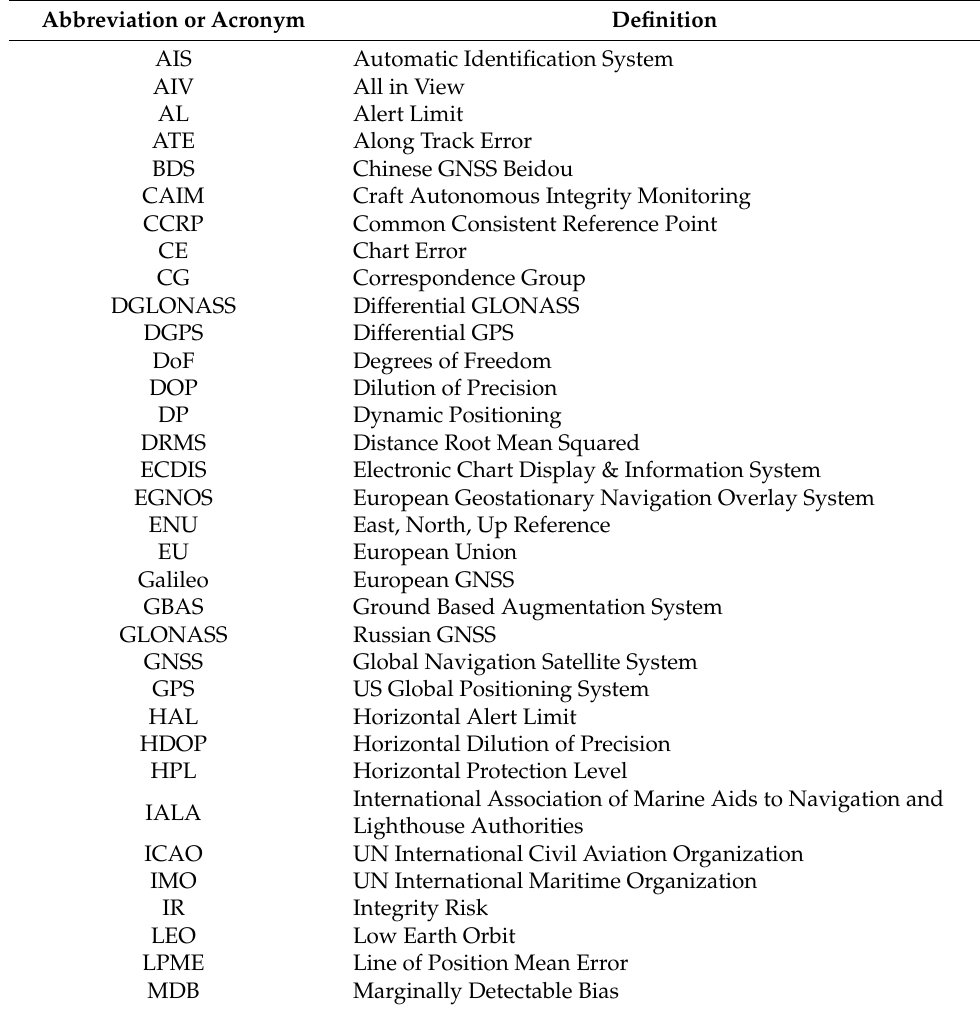
Table A1. Table of abbreviations and acronyms used in the